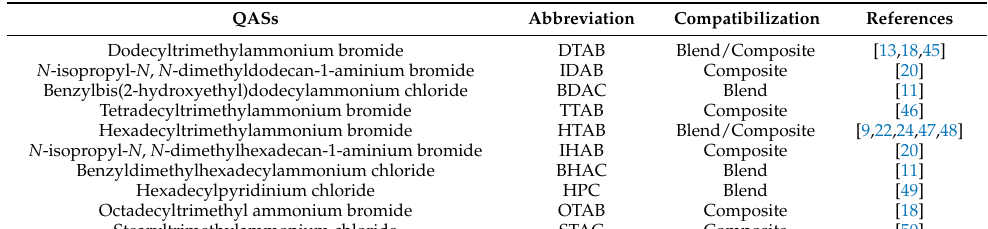
Table 5. Examples of quaternary ammonium surfactants (QASs) applied for compatibilization of polymer blends and polymer composites.